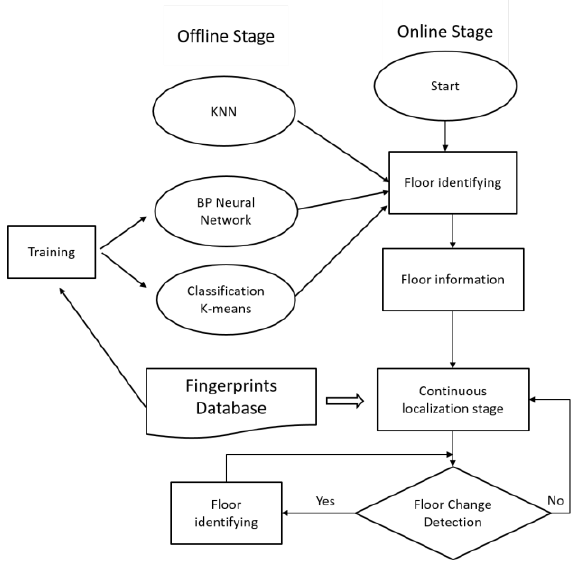
Figure 1. Wi-Fi fingerprints localization with floor